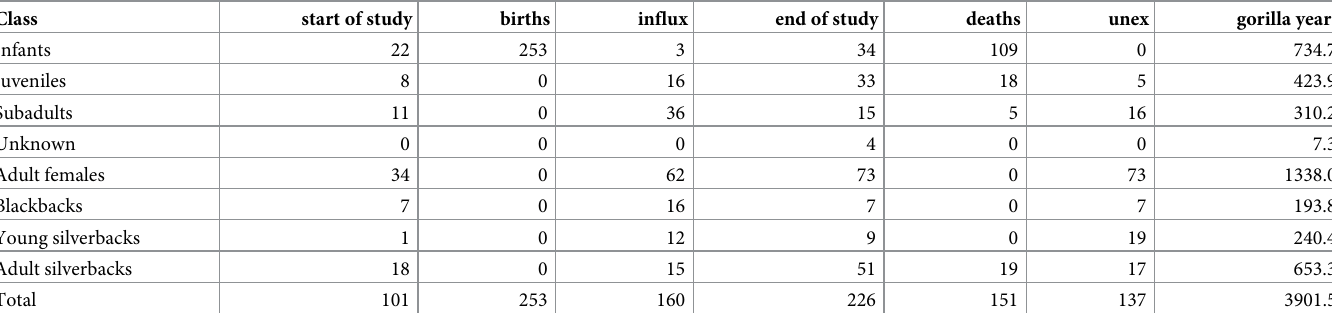
Table 1. Sample sizes for the initial status and final fate of each gorilla in the study.